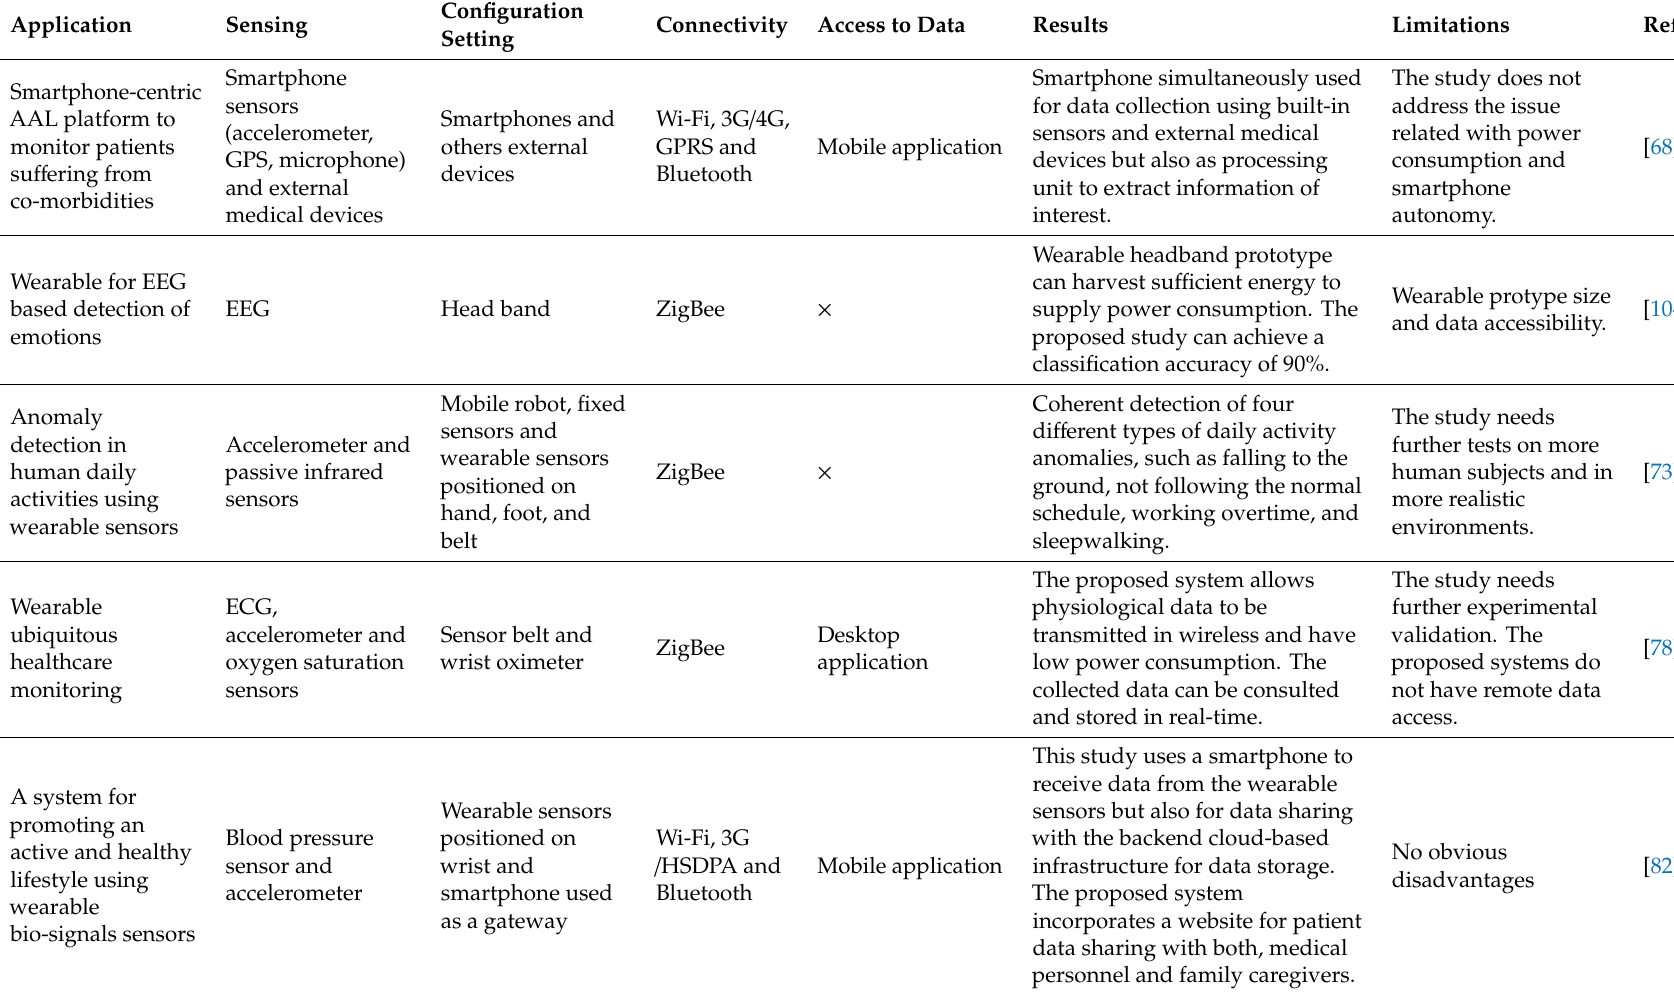
Table 2. Comparison summary on the presented healthcare systems ( × : no